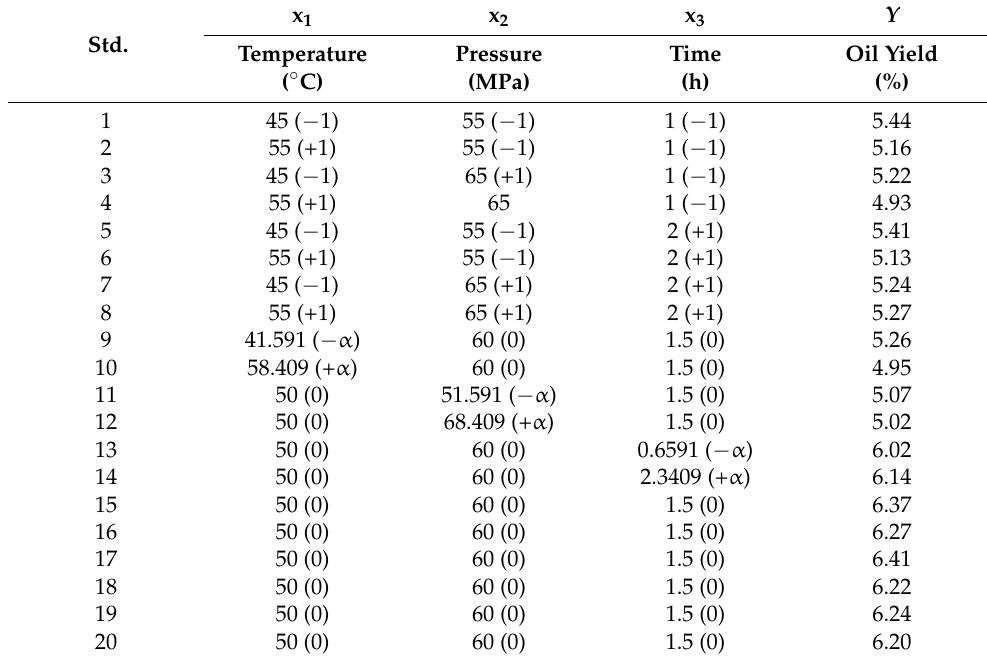
Table 3. CCD design for three factors affecting supercritical CO 2 extraction with assay results.